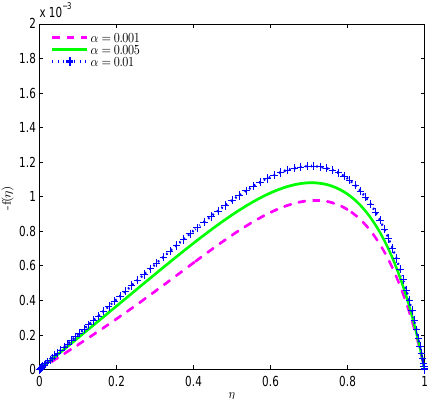
Fig. 7: Variation of f with α at β = 0.005 , γ = 0.01 , Re = 10.0 , K = 10.0 and Λ = 0.001 .